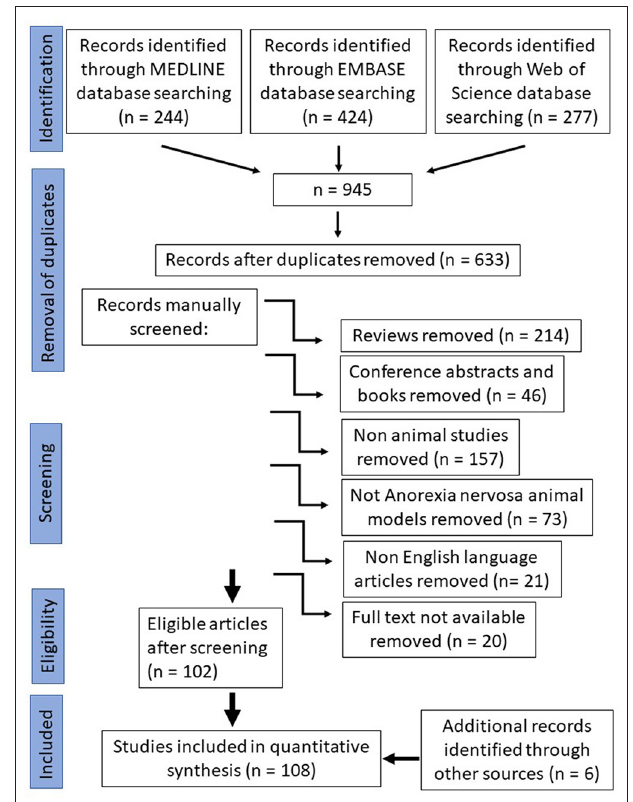
FIGURE 1 | Prisma flow